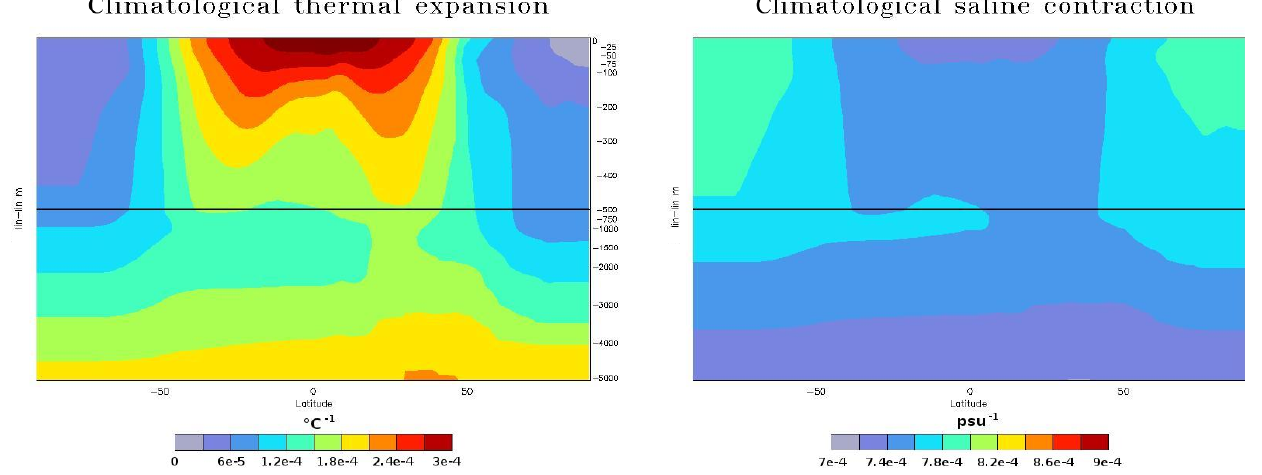
Figure 8. Climatological thermal expansion ( ◦ C − 1 ) and saline contraction (psu − 1 ) as a function of latitude and